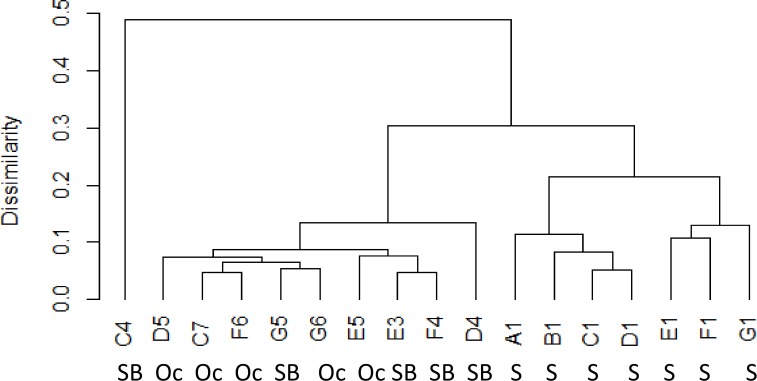
Dendrogram of the average Bray-Curtis distance between sites and site groupings based on phytoplankton count data (S = shelf, SB = shelf break, Oc = oceanic station)